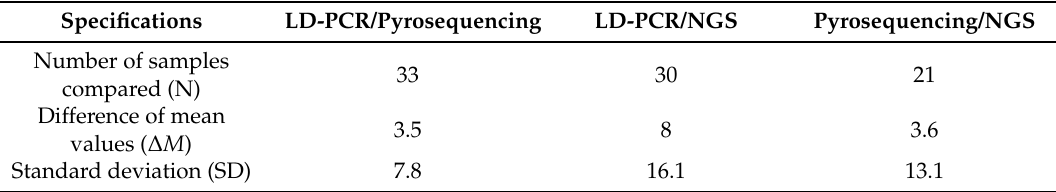
Table 3. Comparison of quantitative mutant subclone assessment using different methods. Overview of results obtained by pairwise comparison of measurements by LD-PCR, pyrosequencing, and NGS on the Miseq platform (based on quantitative values displayed in Table 1). The number of samples amenable to comparison by different methods varies because a proportion of cDNA specimens were not large enough for analysis by all technical approaches. The mean values are not significantly different according to statistical analyses performed by the two sample T -Test ( p = 0.17) or the more refined ANOVA test based on repeated measurements ( p = 0.11), indicating that none of the methods has an obvious bias towards larger or smaller values. However, the SD of ∆ 2 (16.1) in comparison to ∆ 1 (7.8) is significantly higher according to the folded F -Test ( p < 0.0001), indicating the most pronounced differences in test results obtained by LD-PCR and NGS